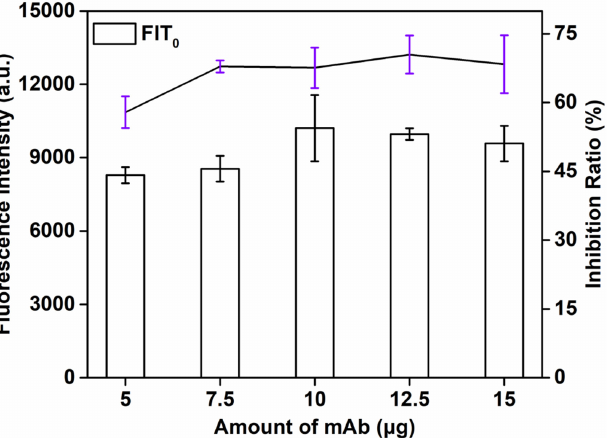
Figure 4. Optimization detection conditions of QBs-LFIA. Effects of amount of mAb.